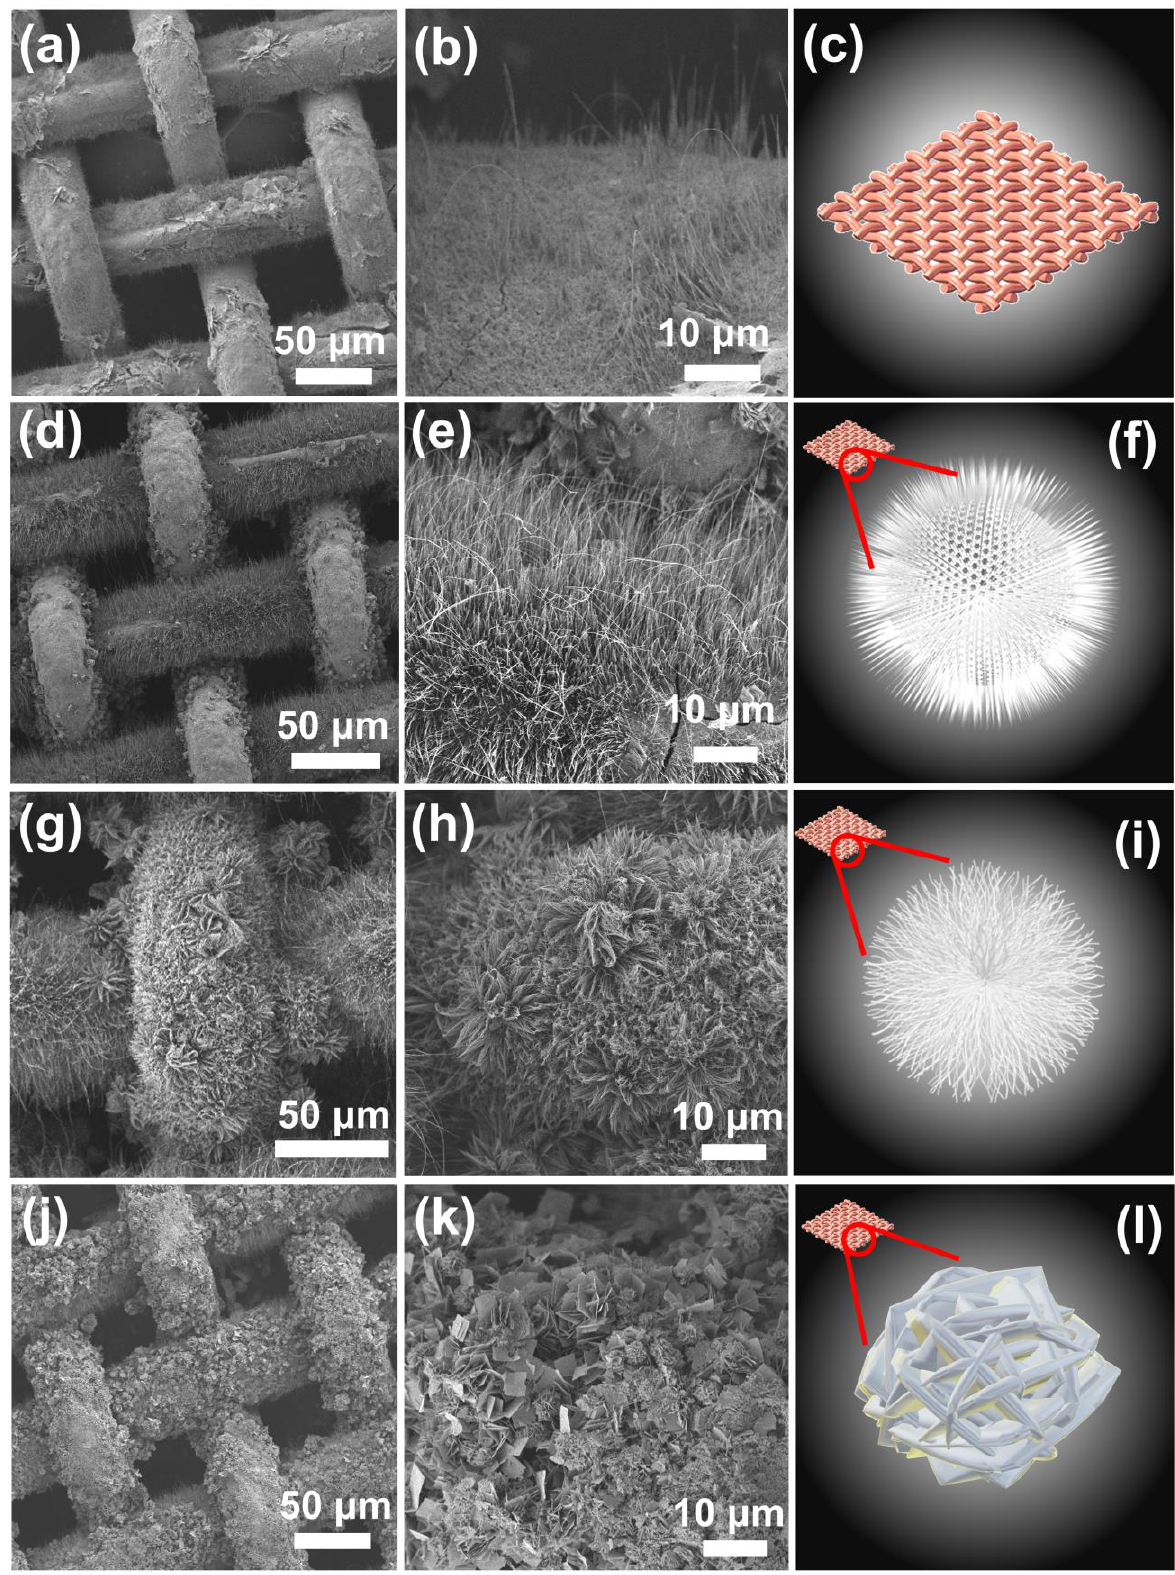
Figure 2. SEM images of ( a – c ) CuOM, ( d – f ) NCCM, ( g – i ) FCCM, ( j – l )